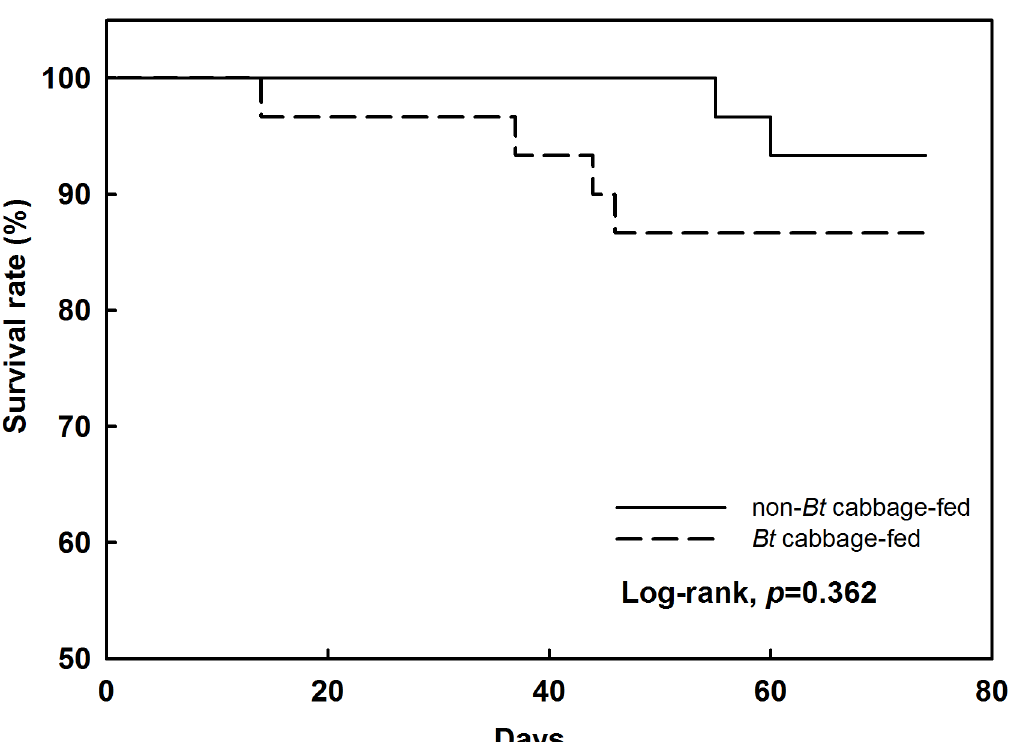
Fig 3. Overall survival of the wolf spider, P . astrigera that had preyed upon D . melanogaster fed with Bt or non- Bt cabbage. Data were derived from Kaplan-Meier curves ( n = 30).